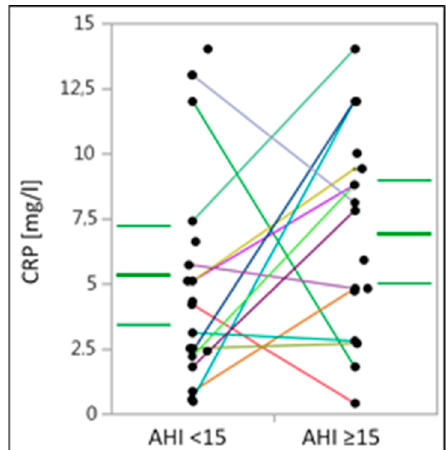
Figure 1. C-reactive protein levels in obese individuals with mild or moderate to severe obstructive sleep apnea. CRP-C-reactive protein. CRP-levels are presented in milligrams per liter. Within the figure, median and IQR are given (bold and thin green lines, respectively) and individuals are visualized using dots and lines for their matching partners. Solitaire points represent individuals without matching partners or missing blood sample values.